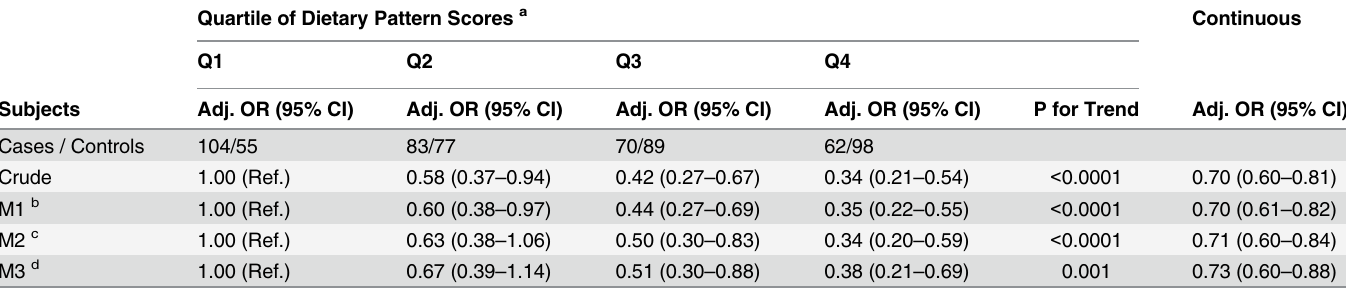
Table 4. Odds Ratios (ORs) of Nasopharyngeal Carcinoma and Corresponding 95% CIs According to Quartiles of Factor Scores and Continuous Factors Scores from Partial Least Squares Discriminant Analysis. Quartile of Dietary Pattern Scores